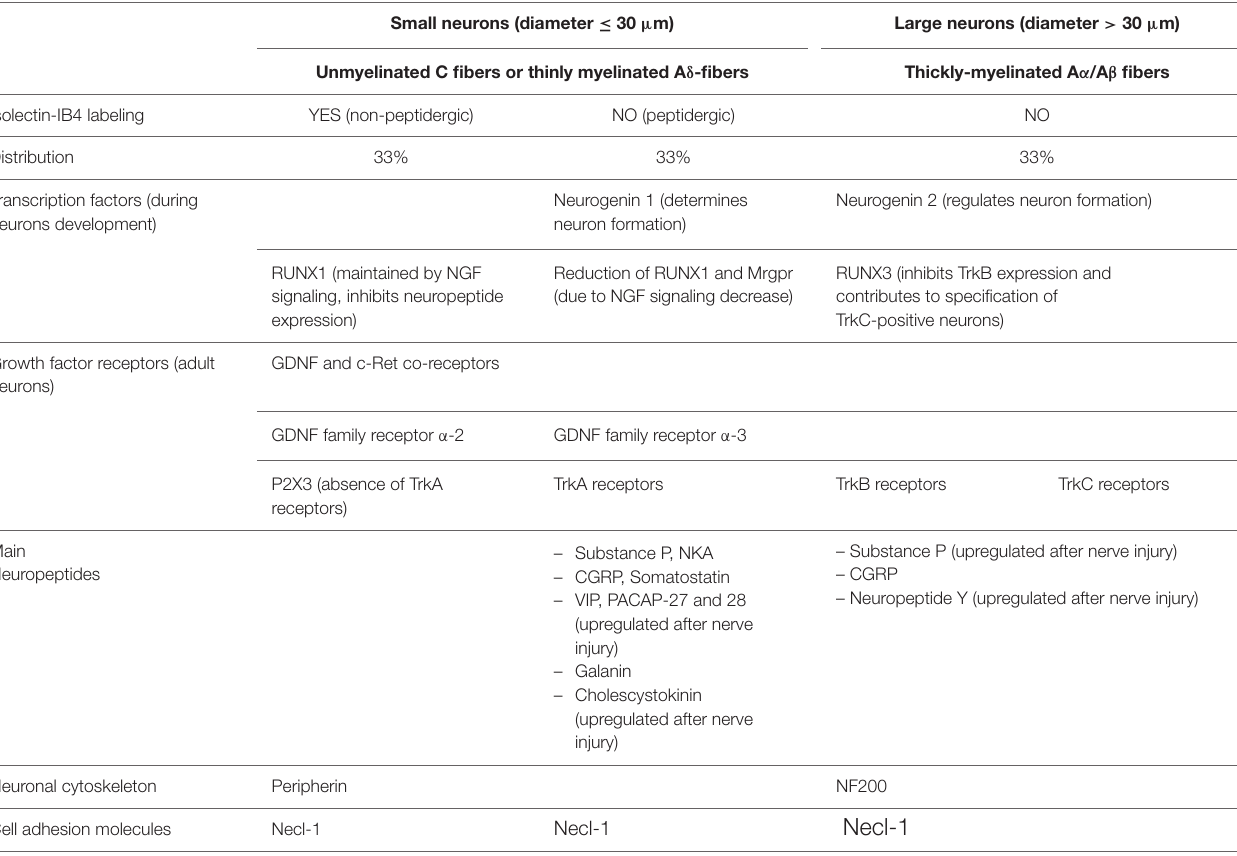
TABLE 1 | Characteristics of DRG